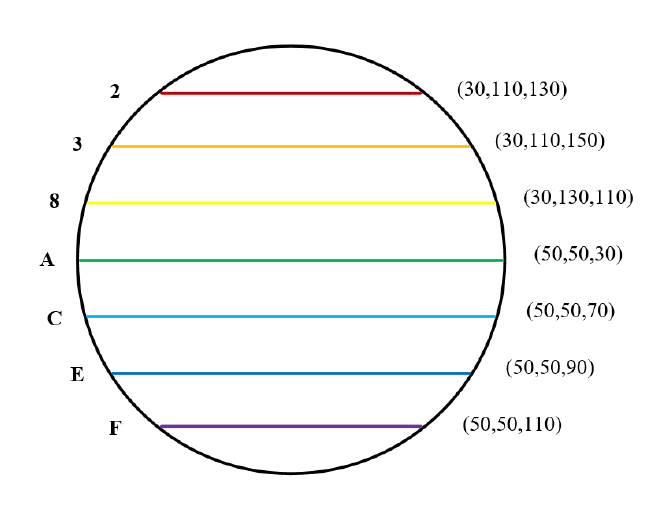
Figure 14. Mapping graph without dynamic transition synchronization.